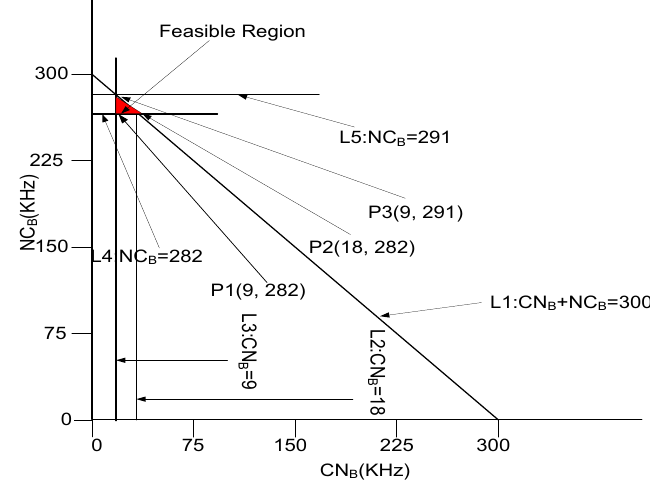
Figure 11. Feasible Region for Throughput